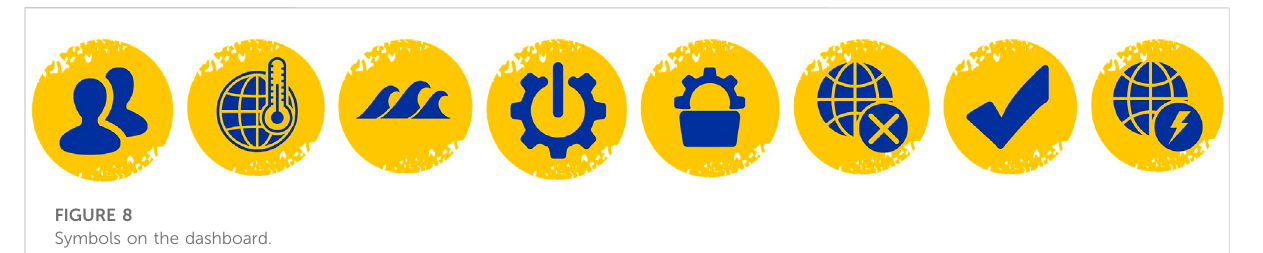
FIGURE 7 First page of the dashboard.